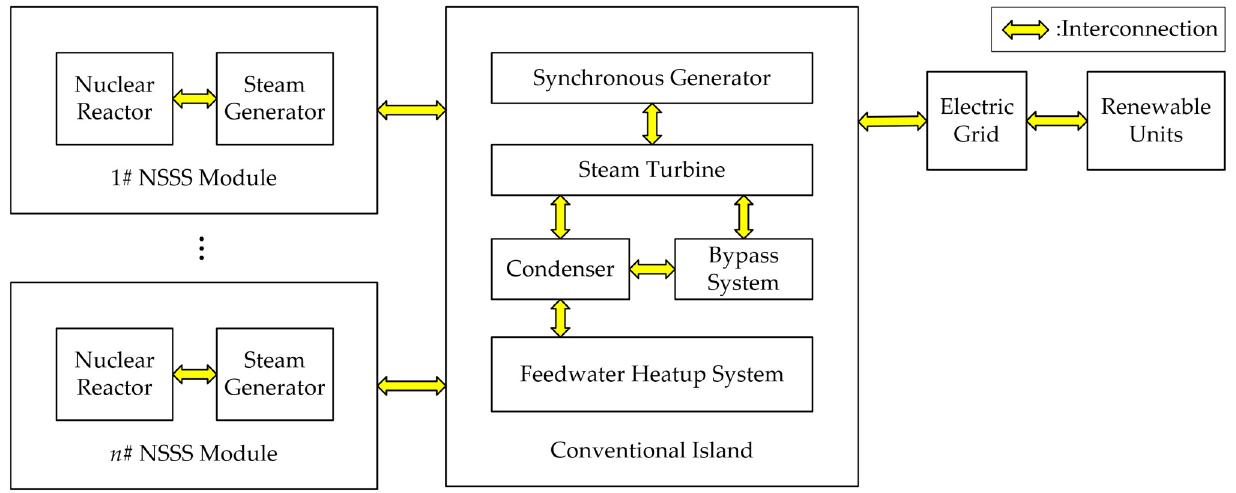
Figure 5. Interconnection amongst systems and equipment of a multimodular mHTGR plant.